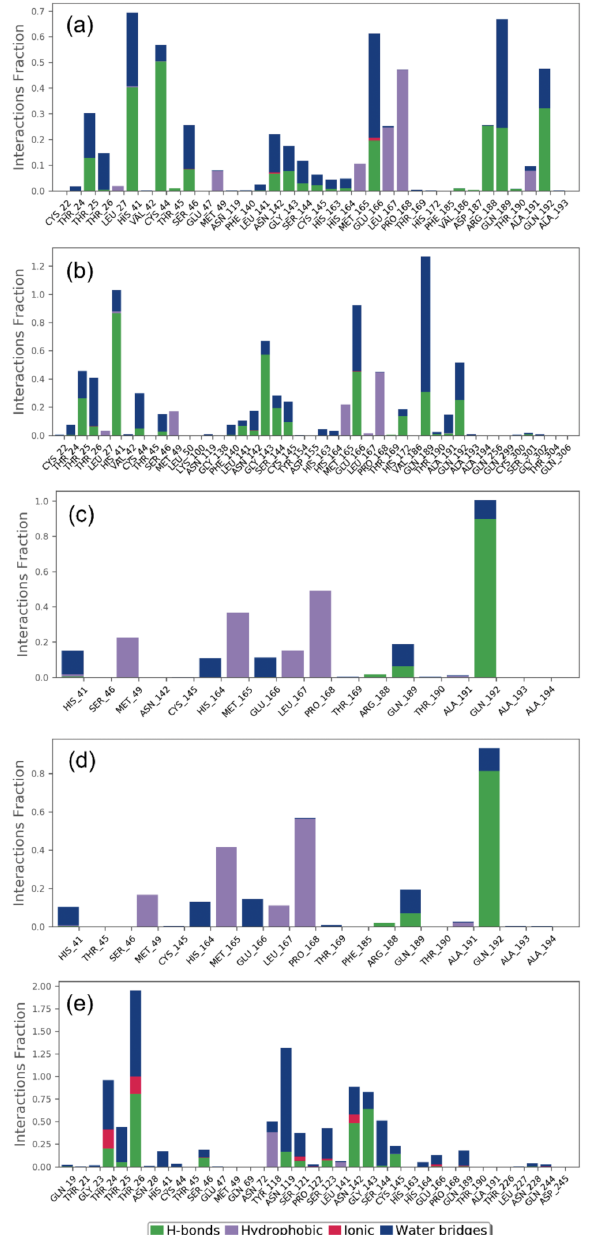
Figure 6. Protein–ligand interaction contacts profiling extracted during a 100 ns MD simulation for SARS-CoV-2 M pro docked with selected compounds: ( a ) licuraside, ( b ) glucoliquiritin apioside, ( c ) 7,3 (cid:48) -Dihydroxy-5 (cid:48) -methoxyisoflavone, ( d ) licuroside, and ( e )